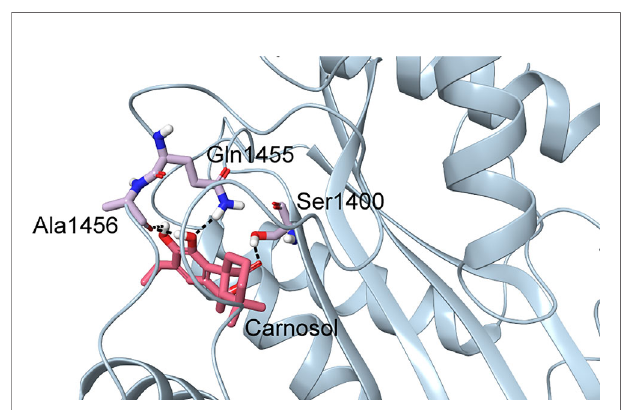
FIGURE 7 | Docked pose of carnosol in the Lys1456Ala p300 structure. The protein structure is shown in blue cartoon representation, and carnosol is shown in pink stick representation. Protein residues that interact with carnosol are shown in lilac stick representation. Hydrogen bonds are represented by black dashed